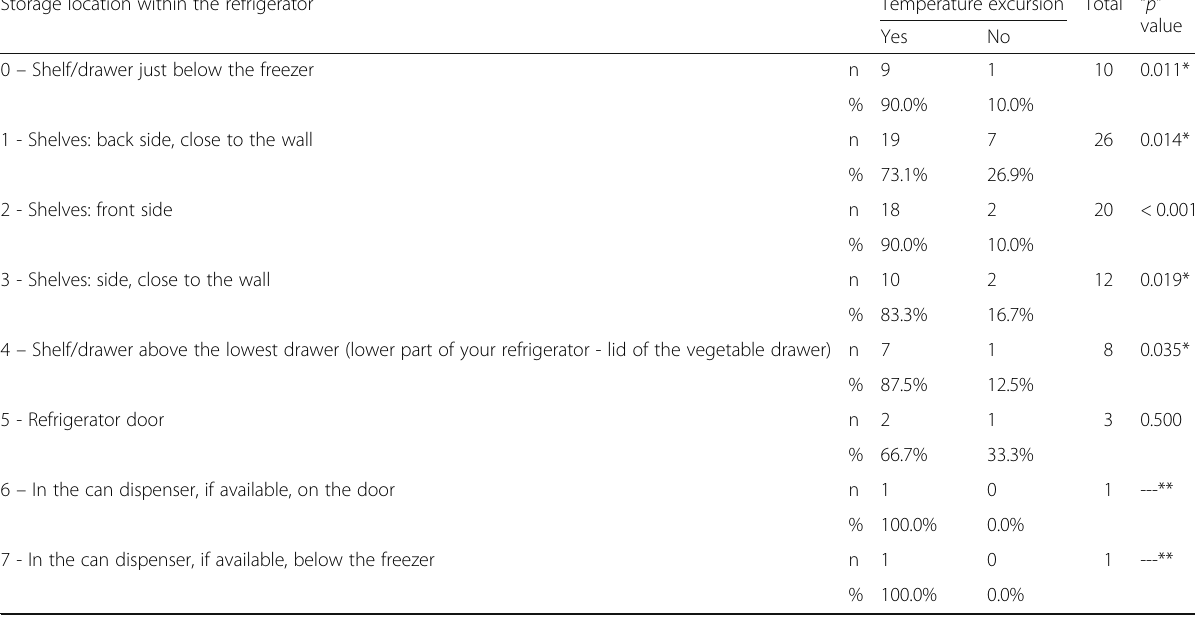
Table 3 Association between storage of biological medication within a refrigerator and occurrence of temperature excursions Storage location within the